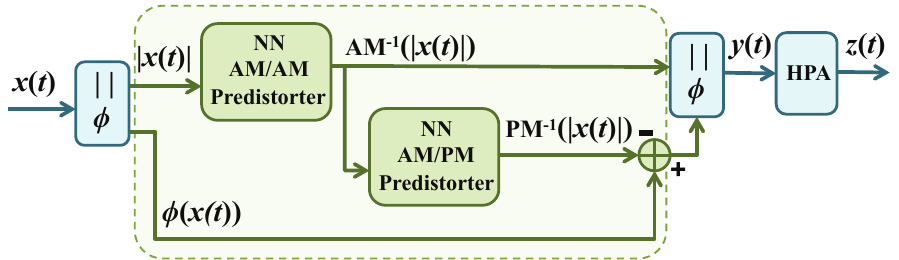
Figure 4. Pre-distorter